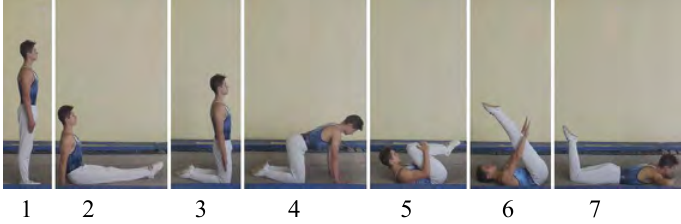
Fig. 2. Elementary exercises of trampoline jumps Block 2. Basic exercises of trampoline jumps are: temp jumps; jump with landing in sitting position; jump with landing on abdomen; jump with landing on knees; jump with landing on knees and hands, touching network; jump with turn by 90° (4 x 90°) in both sides; jump with turn by 180° (2 x 180°) in both sides; jump with turn by 180° and landing in sitting position in both sides; back jump with landing on back, grouping; forward jump with landing on back; forward somersault, grouping; forward somersault, bending; backward somersault, grouping; backward somersault, bending; backward somersault in straightened position (¾ of rotation) with landing on abdomen; jump with turn by 360° in both sides; back somersault, bending, with turn by 360°.